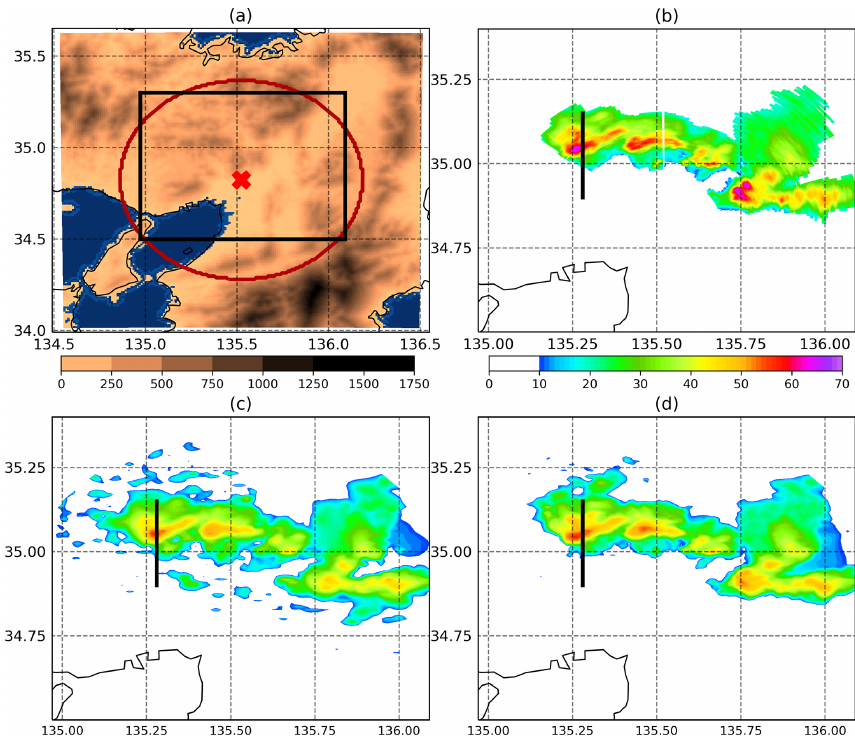
Figure 1. (a) Terrain height of the 1km mesh SCALE–LETKF domain (shades; meters). The red circle indicates the 60km radar range centered at the radar site (red cross) at Osaka University, Suita, Japan. The black box indicates the area shown in panels (b) – (d) . (b) Column maximum PAWR observation (decibel relative to Z; hereafter dBZ) at 05:30UTC, half an hour after the initialization of the data assimilation cycle. (c) 5MIN and (d) 30SEC experiments analysis ensemble mean column maximum radar reflectivity (dBZ) at 05:30UTC. Black lines indicate the locations of the cross sections displayed in Fig.